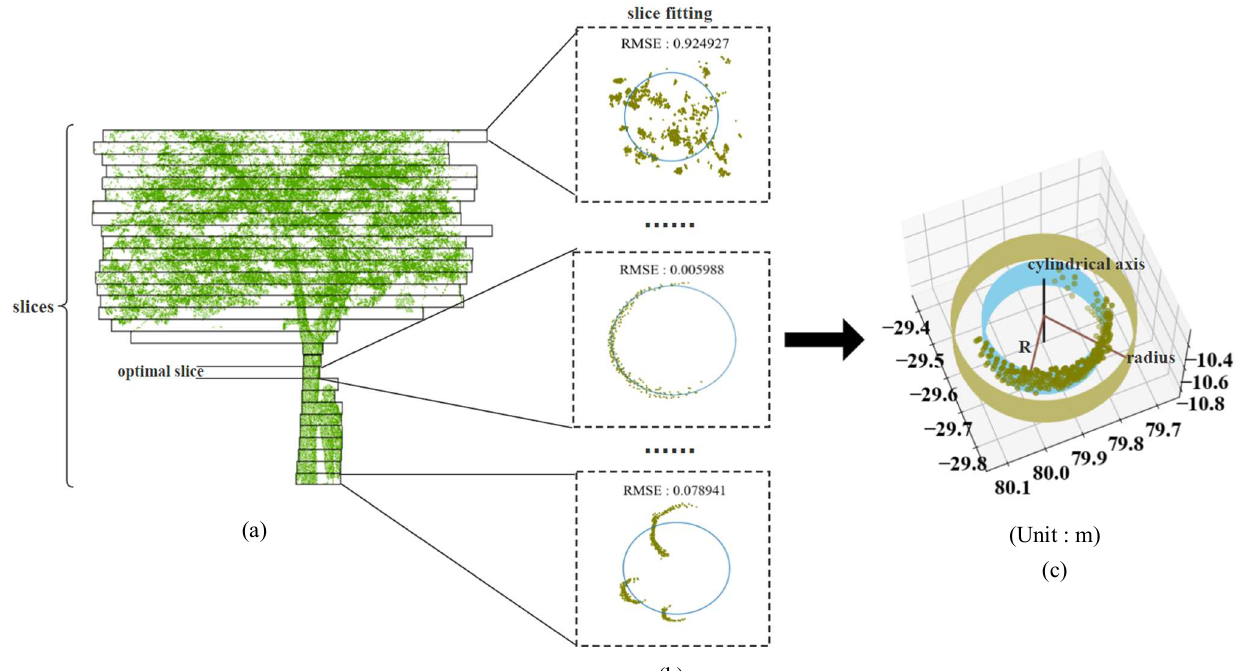
Figure 3. The workflow of trunk–crown separation: ( a ) individual tree layered slices; ( b ) the optimal slice is selected under the condition of minimum RMSE; ( c ) optimal circle segmentation .